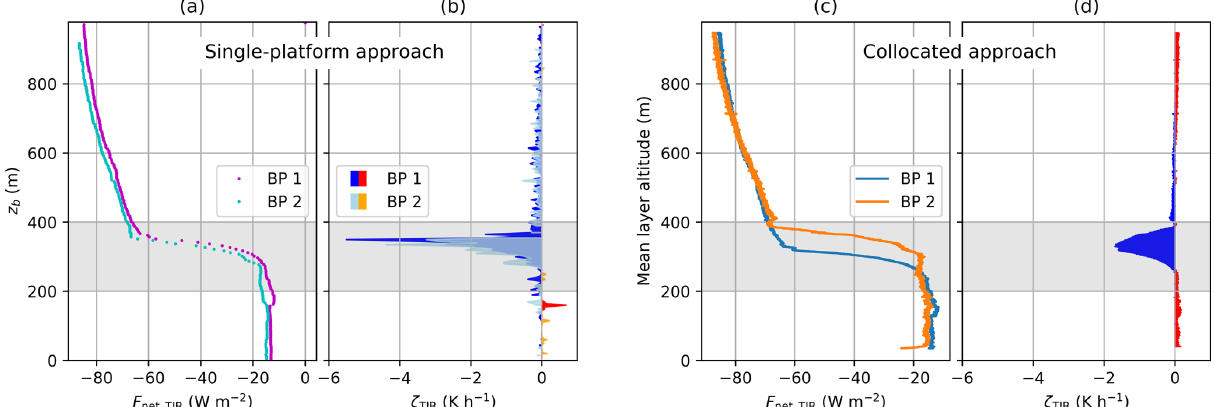
Figure 9. Profiles of net TIR irradiance measured on 5 June 2017, 17:00UTC, with respect to the individual sensor altitude (a) and with respect to the mean altitude of the layer between both platforms (c) . The calculated heating rates are shown for both individual sensors using the single-platform approach (b) and combining both sensors in the collocated approach (d) . Positive values of the heating rate are in red and orange (indicating a warming), and negative values in blue and light blue (indicating a cooling).